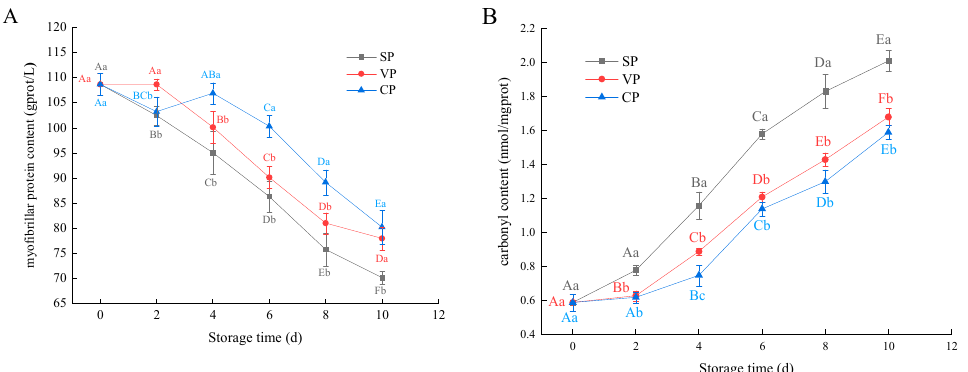
Figure 4. Changes in the myofibrillar protein content ( A ) and carbonyl content ( B ) of pike eels during 10 days of chilled storage. SP, simple packaging; VP, vacuum packing; and CP, stable chlorine dioxide pretreatment combined with vacuum packing. Different uppercase letters indicate significant differences in the MPs and carbonyl content of pike eels during 10 days of chilled storage ( p < 0.05). Different lowercase letters indicate significant differences in the MPs and carbonyl content of pike eels for the same storage time ( p < 0.05).